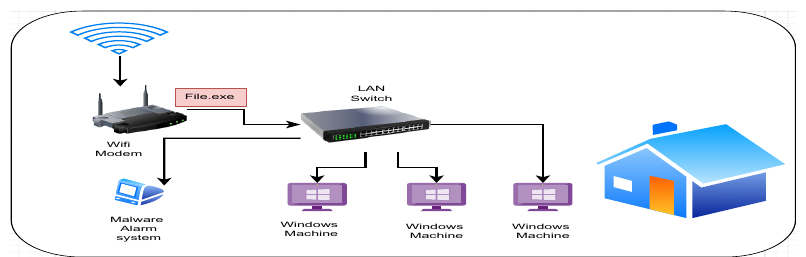
Figure 1. Malware detection scenario